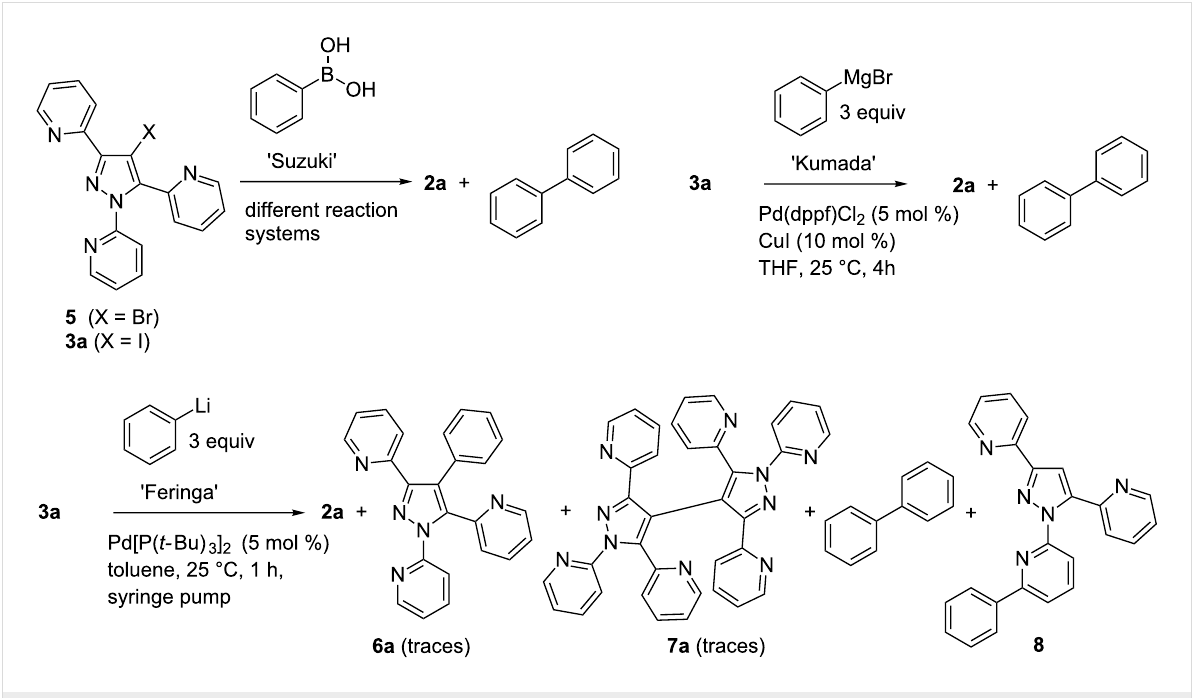
Scheme 4: Attempted cross-coupling reactions with 4-halopyrazoles 5 and 3a